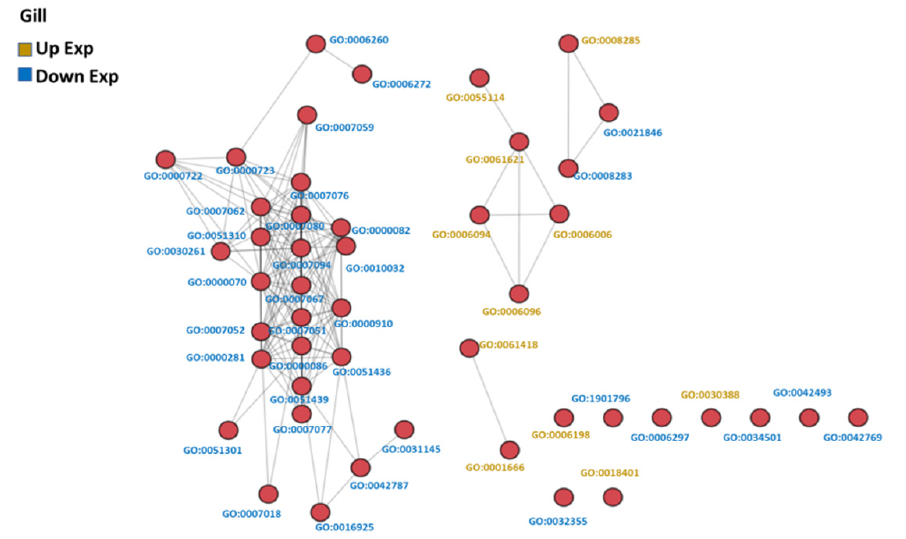
Figure 4. GO similarity network analysis of common carp gills in hypoxia: The three similarity scores and three association scores were computed for each GO term pair, and a bubble network map was created.